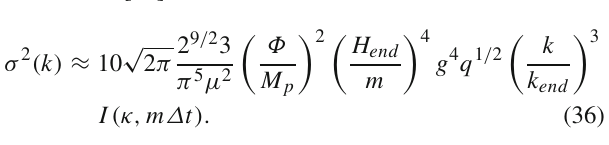
The blue region shows the threshold σ thresh = 0 . 08 at which PBH are overproduced. The left panel presents the case of m Δ t = 25 , while in the right panel m Δ t =